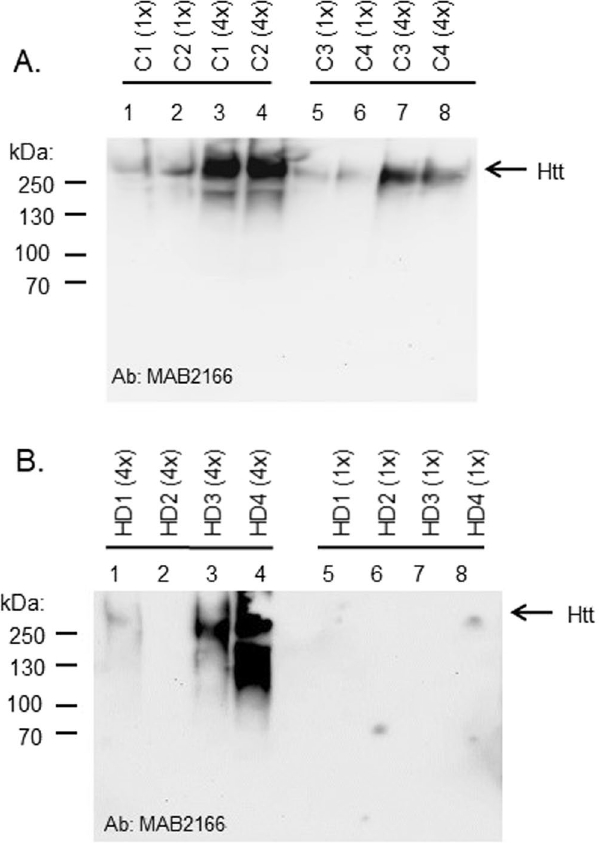
Figure 1. ( A ) Western blot of Htt protein in saliva from normal and HD individuals. Three milliliters of unstimulated whole saliva was collected from four normal individuals (C1-C4). Saliva supernatants were used as-is or were concentrated 4-fold by vacuum centrifugation. Supernatant fractions were separated by 7% SDS-PAGE and blotted onto nitrocellulose membranes for immunodetection using MAB2166 antibody, a monoclonal anti-huntingtin antibody which recognizes a fragment of the protein (amino acids 181–810), located outside the polyglutamine region. Gel image was acquired using a Fluorochem E imager. ( B ) Western blot of Htt protein in saliva from HD patients carried out as in ( A